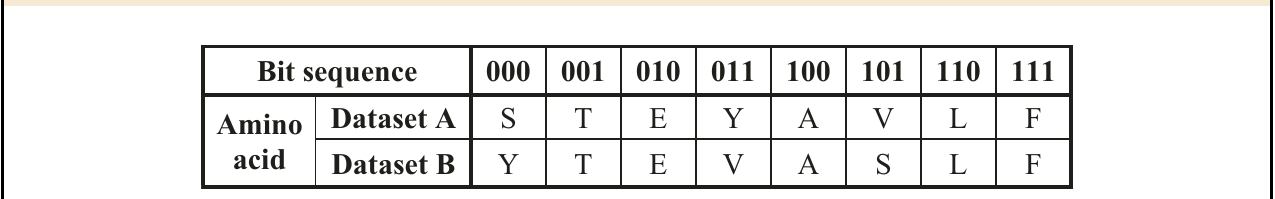
Table 1 The one-to-one mapping of bit sequences to amino